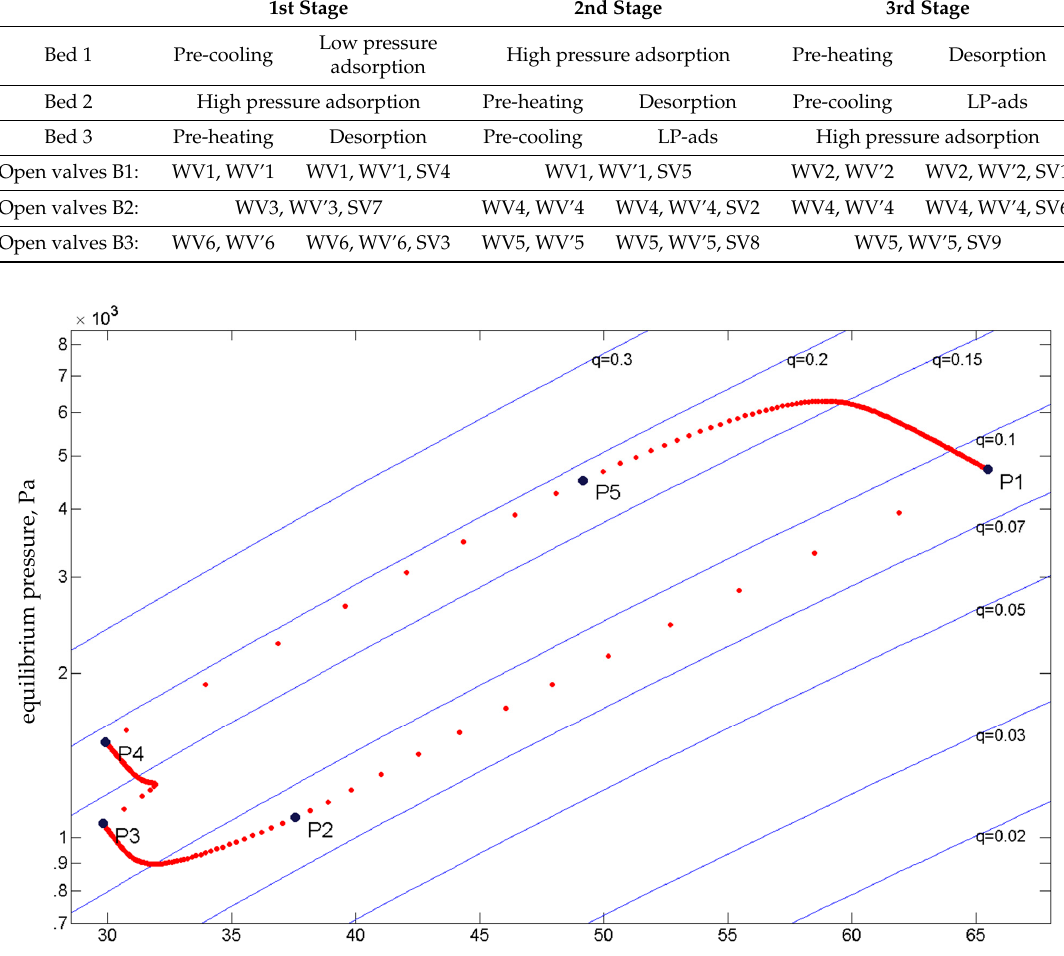
Figure 5. Bed working cycle shown as equilibrium pressure and adsorbent temperature dependency.